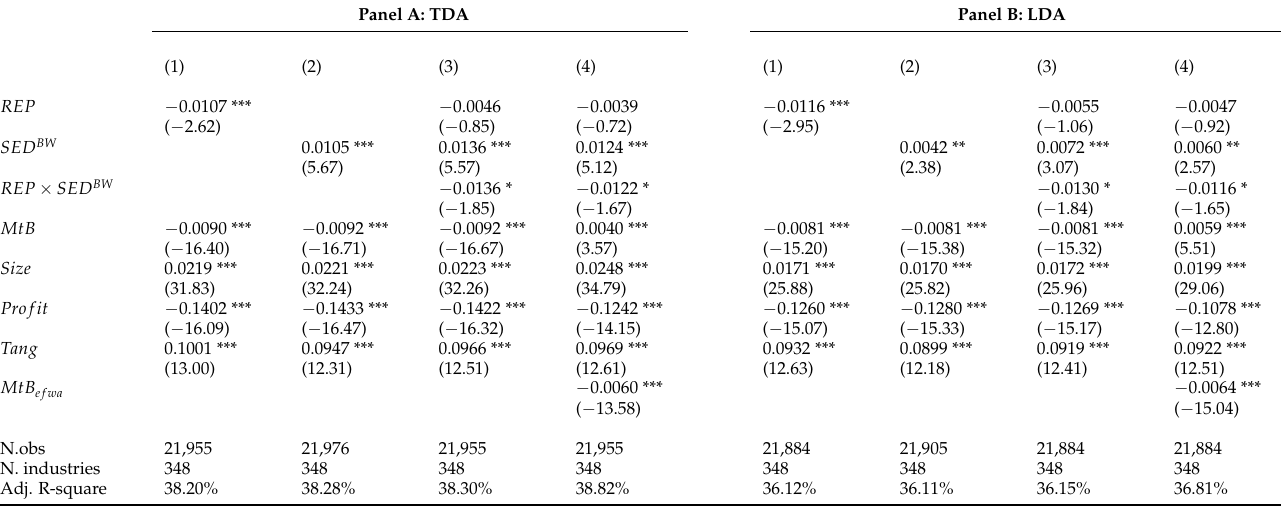
Table 2. Investor Sentiment, Republican Managers, and Financial Leverage. Panel A: